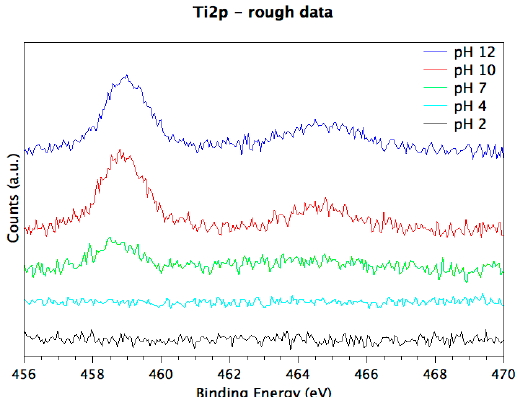
Figure 6. XPS N1s spectra collected on the four monolayer (ML) samples prepared with decreasing pH values.